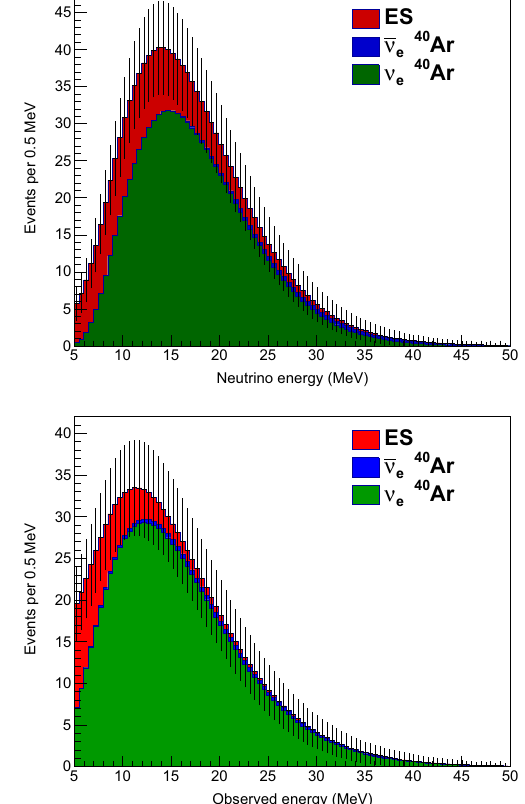
Fig. 10 Top:Spectrumasafunctionofinteractedneutrinoenergycom- puted with SNOwGLoBES in 40 kton of liquid argon for the electron- capture supernova [8] (“Garching” model) at 10 kpc, integrated over time, and indicating the contributions from different interaction chan- nels.Nooscillationsareassumed.Bottom:expectedmeasuredspectrum as a function of observed energy, after detector response smearing